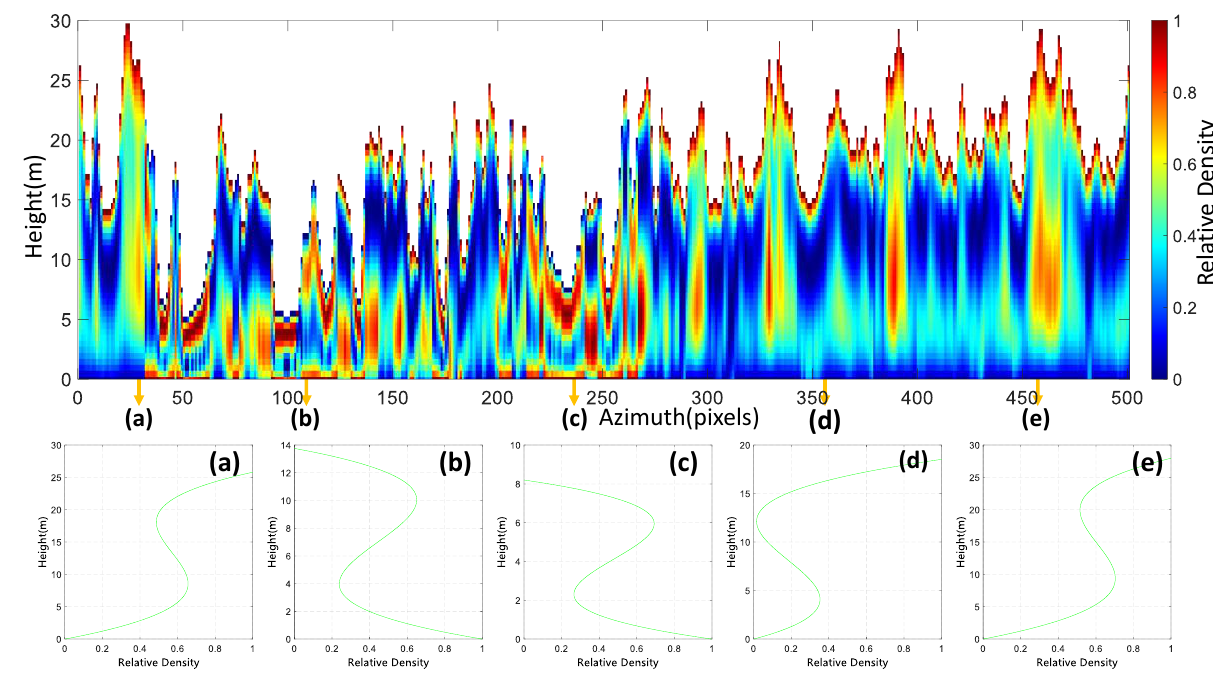
Figure 9. Inversion results of vertical profiles of boreal forests using dual-baseline PolInSAR data based on the PCT model. The top panel shows the vertical structural polarization tomogram of the area covered by the red line in the yellow rectangular box in Figure 10c, and ( a – e ) represent the profile functions of the 30th, 110th, 235th, 355th, and 460th pixels, respectively, in the above polarization tomogram.